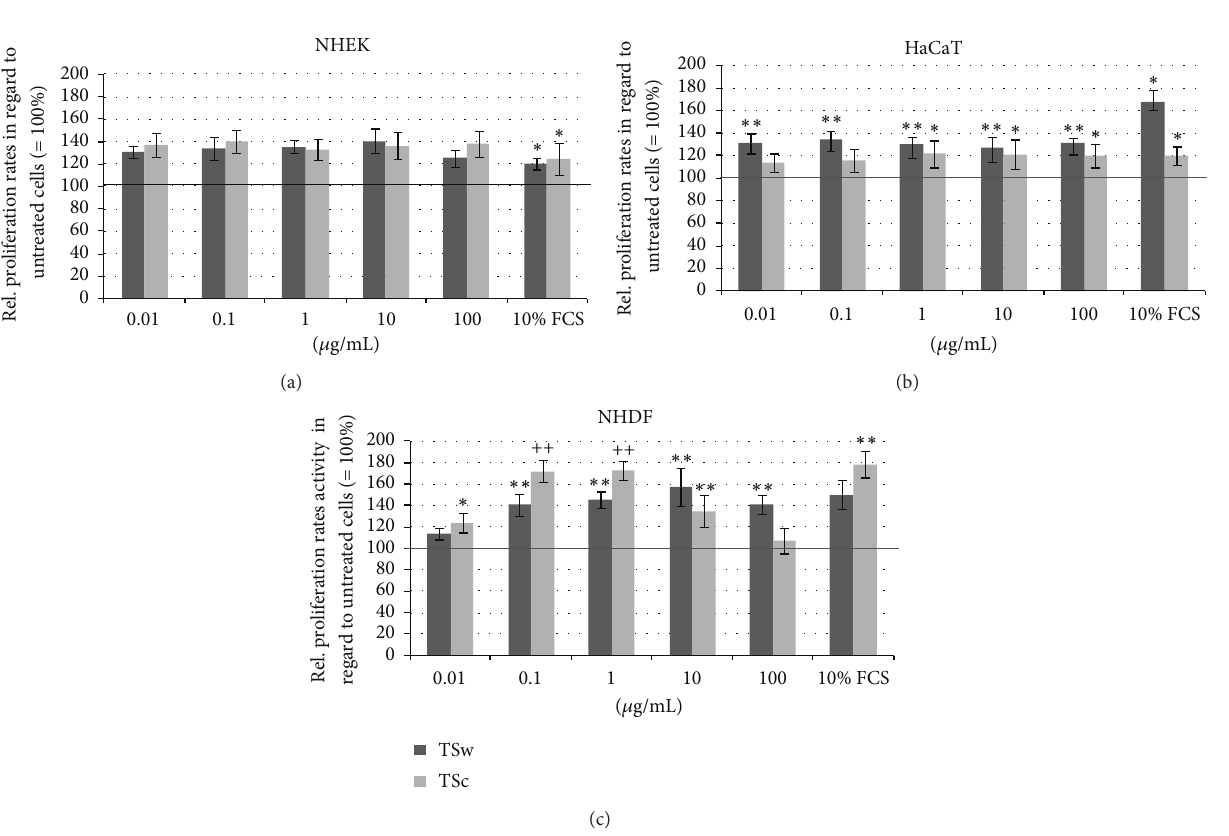
Figure 2: BrdU incorporation as marker for cell proliferation. NHEK (a), HaCaT (b), and NHDF (c) were incubated with TSw and TSc in concentrations of 0.01–100 𝜇 g/mL for 48h. Mean values ± SD of 𝑛 = 8 replicates of three independent experiments are shown with ∗ 𝑃 < 0.05 and ∗∗ 𝑃 < 0.01 compared to untreated cells as well as with ++ 𝑃 < 0.01 compared to cells treated with 0.01 𝜇 g/mL and 10 𝜇 g/mL TSc; 10% FCS = positive control. Results were normalized to untreated cells (=100%, black line).